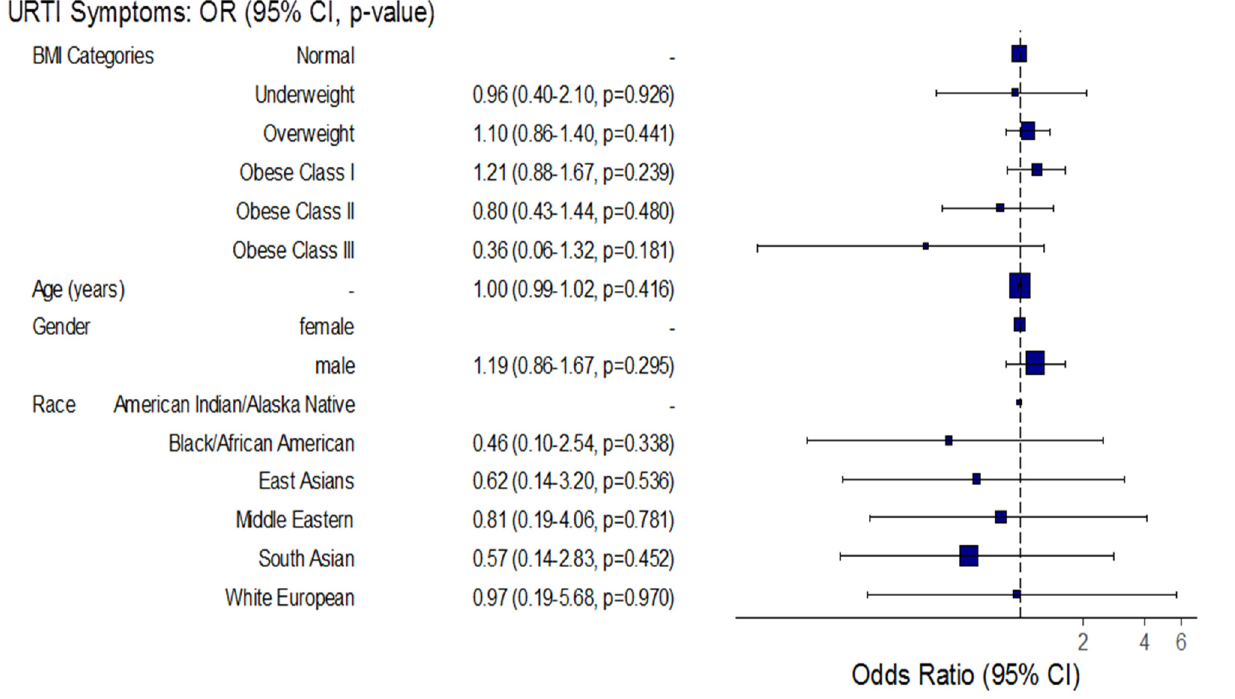
Figure 6. Forest plot for the association between BMI and the incidence of upper respiratory tract infection among hospitalized COVID ‐ 19 patients. BMI: body mass index; CI: confidence interval; URTI: upper respiratory tract infection; OR: odds ratio.